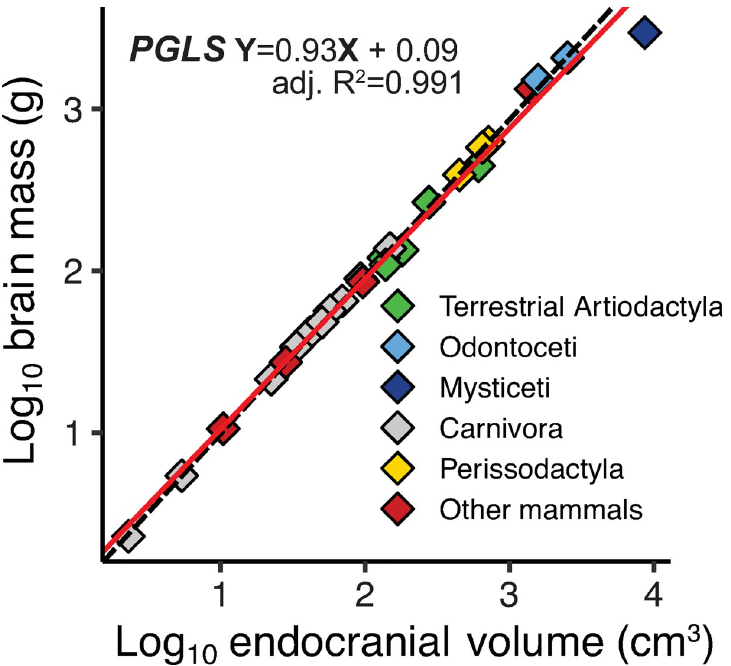
Fig 4. Plot of log transformed brain mass and endocranial volumes. Scaling of brain mass and endocranial volume in adult extant placental mammals (species averages); the bowhead (dark blue diamond, farthest upper-right) is the only